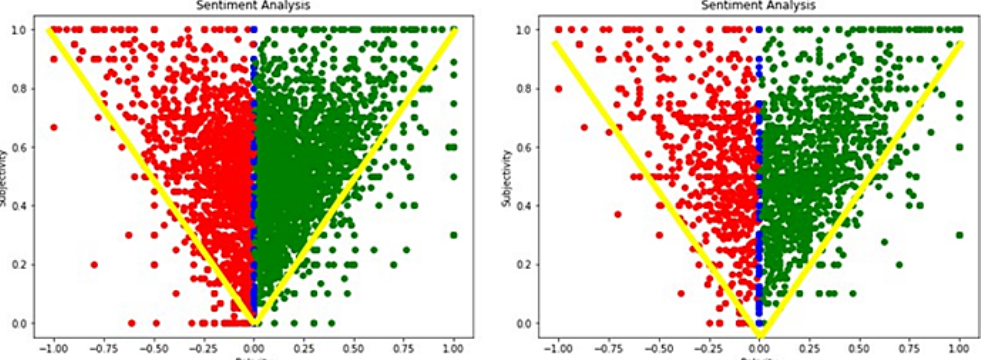
Figure 9. Subjectivity vs. Polarity Graph for #SSR and #JusticeForSSR.